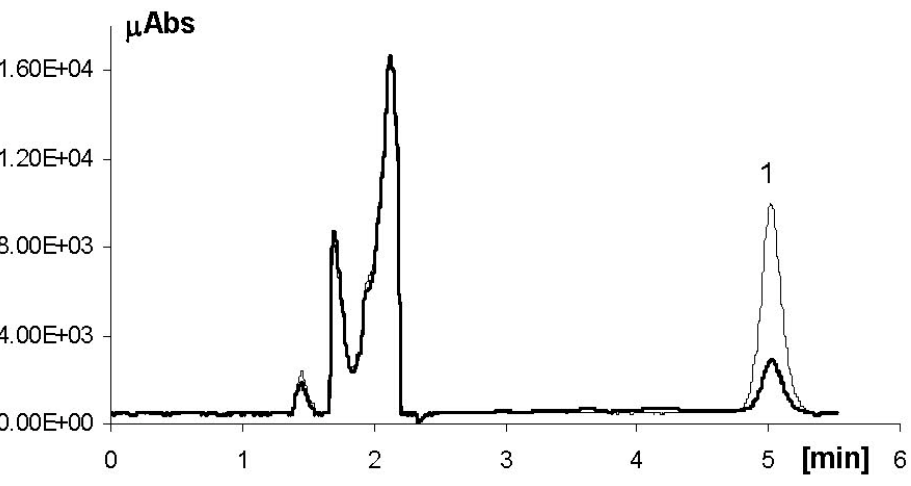
Figure 2. Representative HPLC-UV chromatogram of a cream preparation containing EGCG before (thin line) and after (thick line) 1 h irradiation with the solar simulator. Peak 1 =